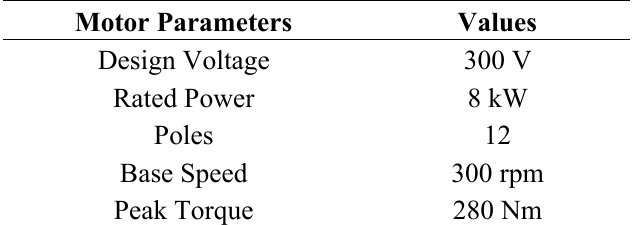
Table 1. Specifications of the induction motor.